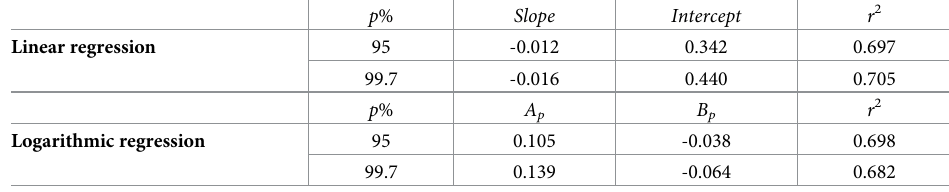
Table 1. Linear and logarithmic regression descriptors for the 95% and 99.7% confidence intervals of the head